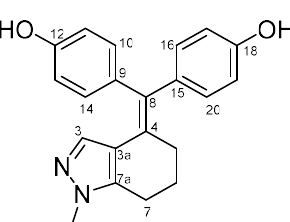
Scheme 20. Structure of 33 with the numbering of atoms used for the assignment of NMR data. inseparable component identified by NMR measurements (Scheme 21).